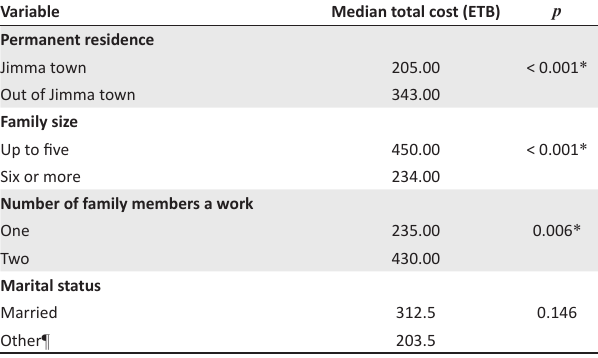
TABLE 3: Mann–Whiney U test of difference in the median total cost of the disease (in Ethiopian birr). Variable